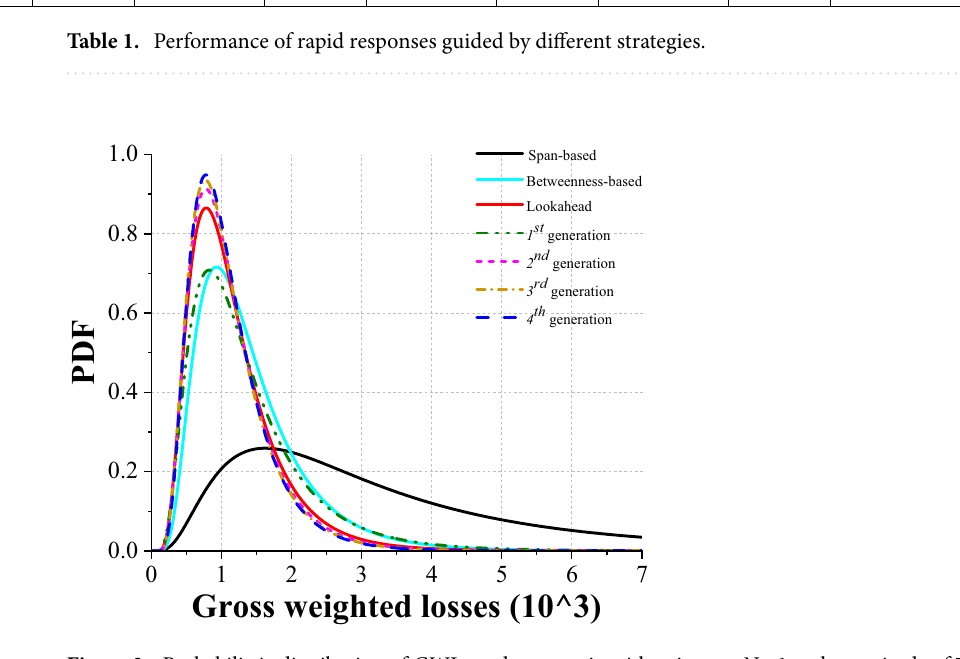
Figure 3. Probabilistic distribution of GWLs under scenario with epicentre No. 1 and magnitude of 7. 1000 simulations have been run for the rapid response under each of the different strategies. Accordingly, probabilistic density functions ( PDF ) has been fitted based to the dataset obtained from those simulations. The contrast among the behaviour of the rapid response according to those strategies as measured by GWL , is thus